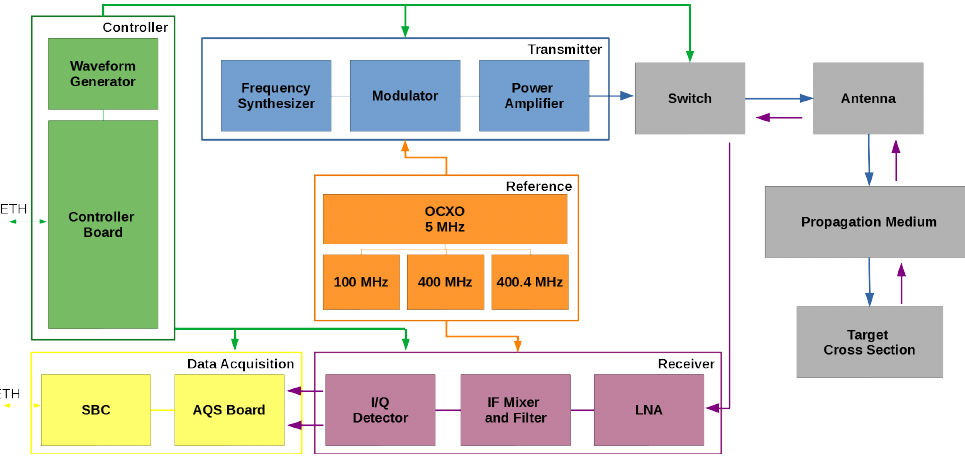
Figure 1. ATLAS system block diagram. Table 1. Comparison between ATLAS and other tracking